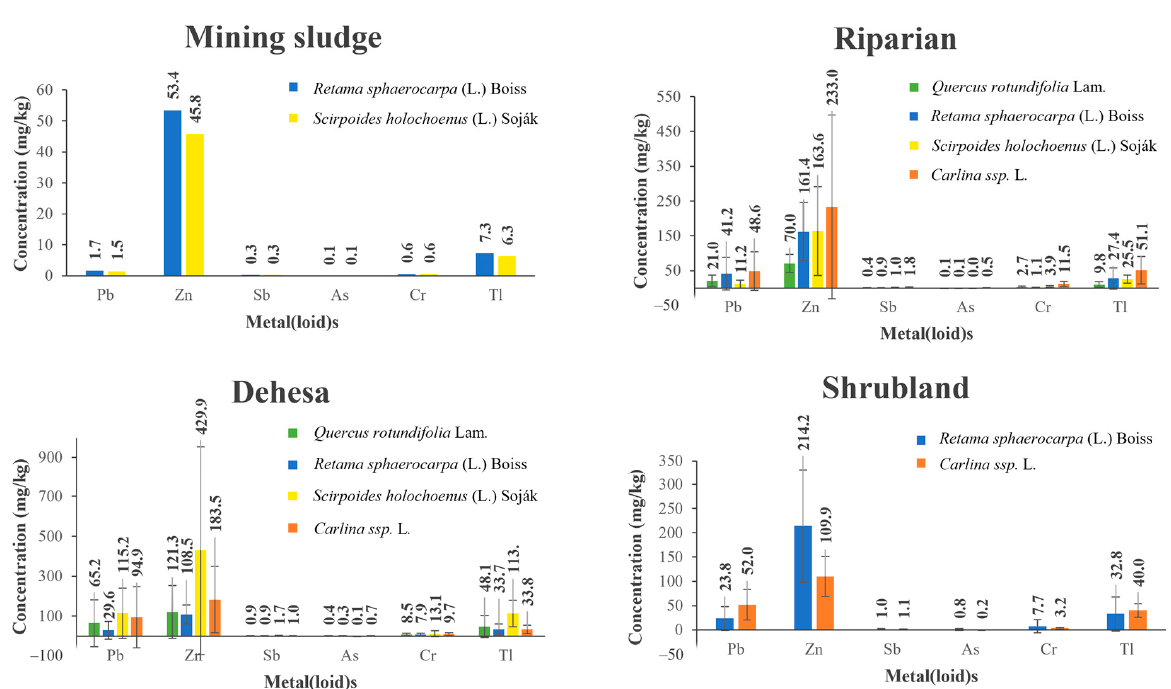
Figure 6. Average concentration of metal(loid)s in vegetation. Mining sludge (n = 4), riparian (n = 29), dehesa (n = 49), shrubland (n = 8).